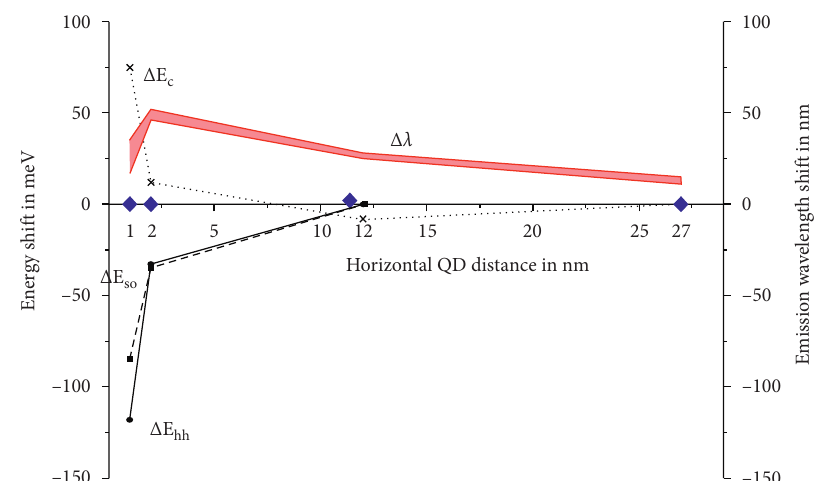
Figure 3: Numerical results on the impact of horizontal/in-plane coupling of GaAs × 3 square array, 0.3 Sb 0.7 QDs on GaAs arranged in a 3 with an assumed horizontal QD distance of 1 nm, 2nm, 12nm, or 27nm, respectively. The lines are only guides to the eye. The quantities ΔE c , ΔE hh , and ΔE so are the shifts of the bulk conduction ( c ) band edge, the bulk valence band edge for heavy holes ( hh ), and the bulk valence band edge for split-off holes ( so ), respectively. For the energy level shifts the mean values for the nine QDs are reported here. For the luminescence emission wavelength shift Δλ a range is given via the light-red shaded area.